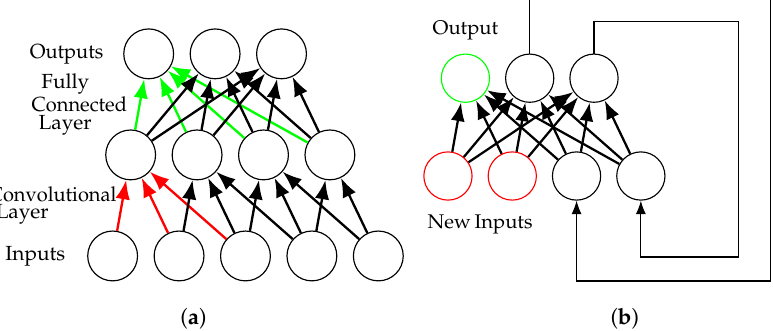
Figure 5. ( a ) A toy CNN example. Only neighboring neurons are connected to the neuron in the next layer (highlighted in red), whereas all neurons in the previous layer are connected to the next layer neuron in fully-connected layers (highlighted in green). ( b ) A simplified example of an RNN cell. The network inputs are the combination of history outputs (indicated using arrows) and the new input samples (highlighted in red). Parts of the output neurons are network outputs (highlighted in green).